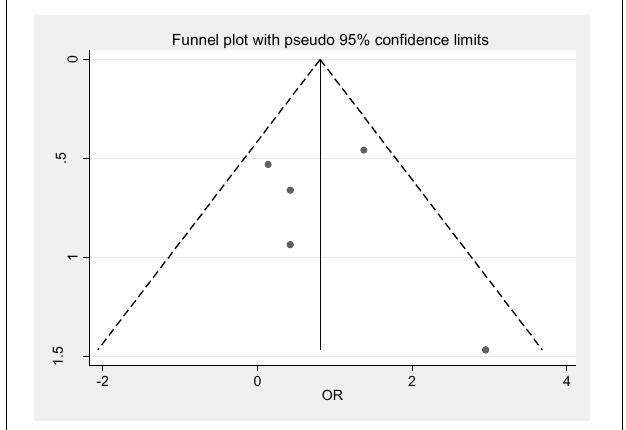
FIGURE 3 | Publication bias based on a funnel